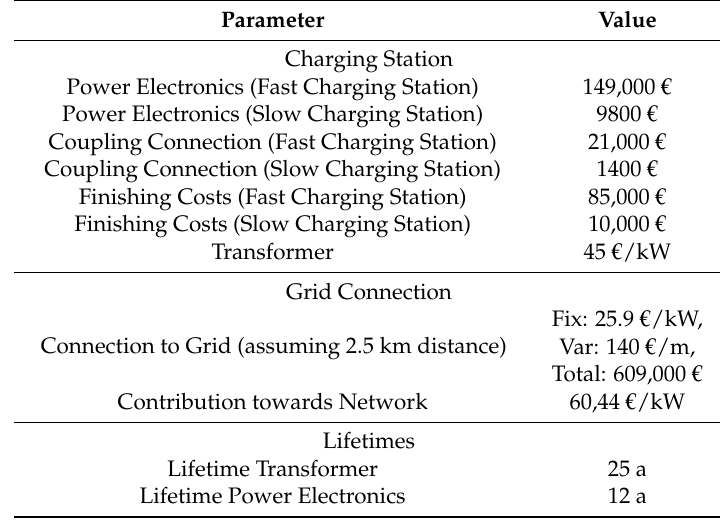
Table A4. Cost parameters for charging station infrastructure. The source for the costs parameters in this table is private communication with manufacturers, who want to stay anonymous [30].